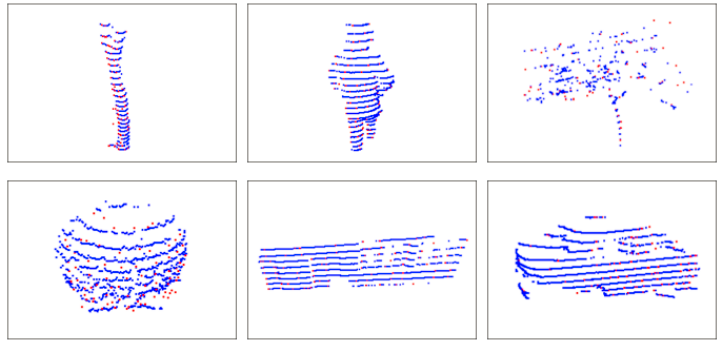
Figure 7. The critical point selection examples generated by the multi-scale critical point sam- pling method.